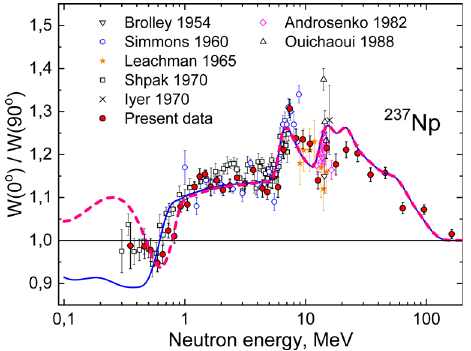
Figure 4. Anisotropy of FFs for 237 Np compared with old ex- perimental data from [12, 13, 15, 16, 19–21]. Error bars are the statistical errors. The solid and dashed lines are the variants 1 and 2 of our model calculations, respectively (see text).